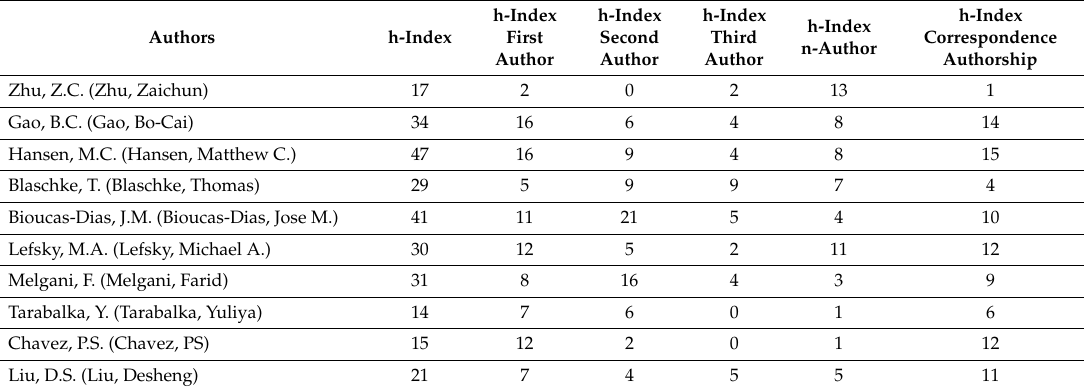
Table 5. A nuanced version of h-index (nh-index) of 10 authors, randomly